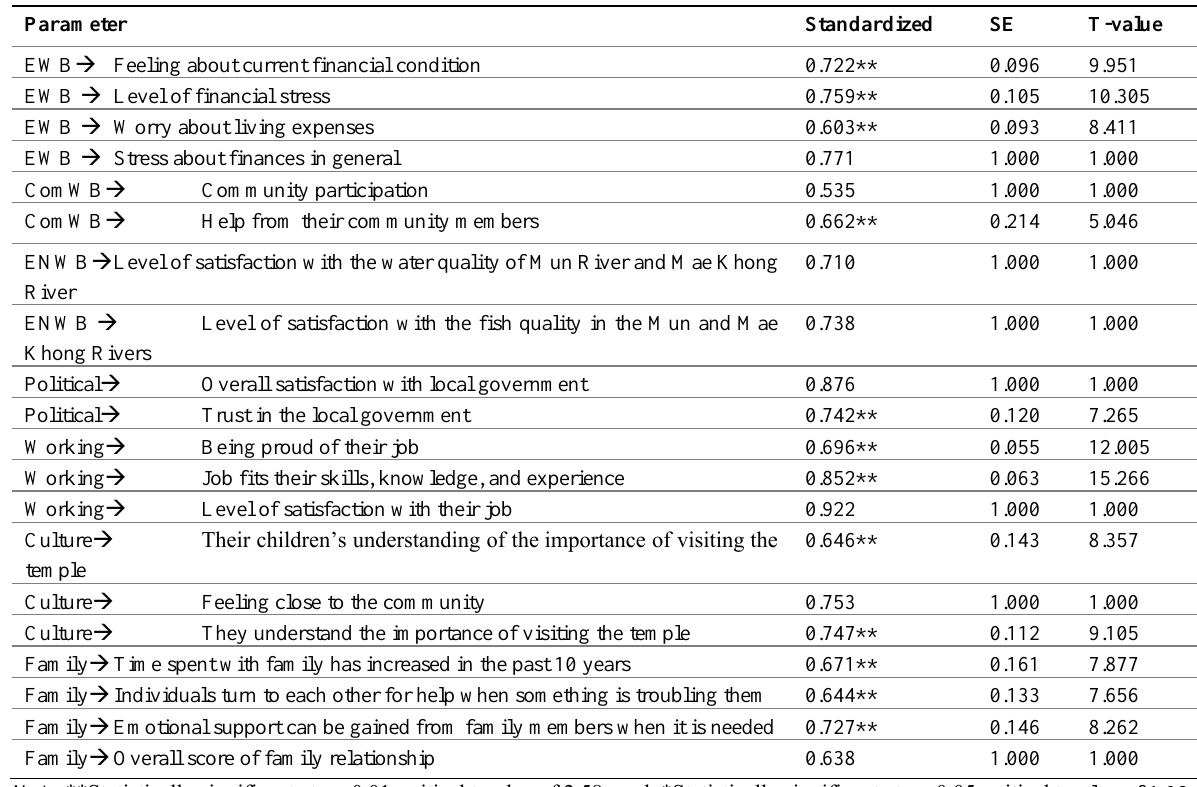
Table 5: Result of Seven Well-Being Dimensions Impacting Overall Well-Being(Chaiyamart, 2021). Parameter